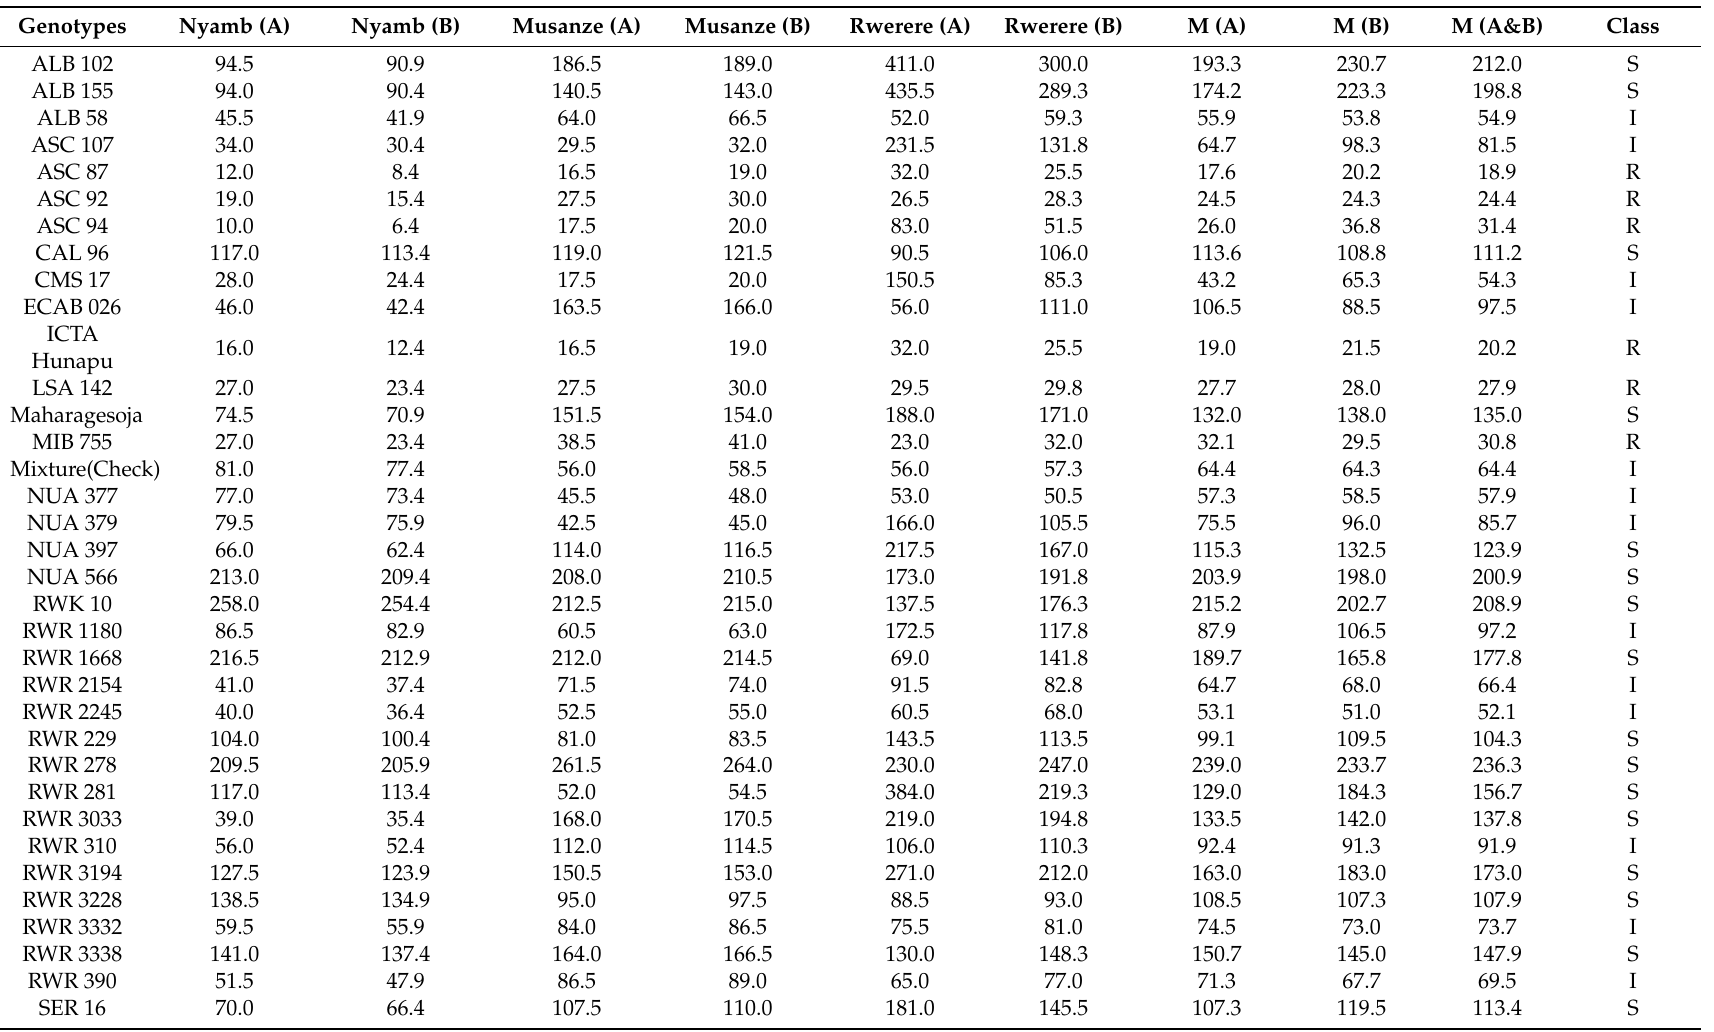
Table 4. Average RAUDPC for ascochyta of 39 bush bean genotypes tested in six environments in